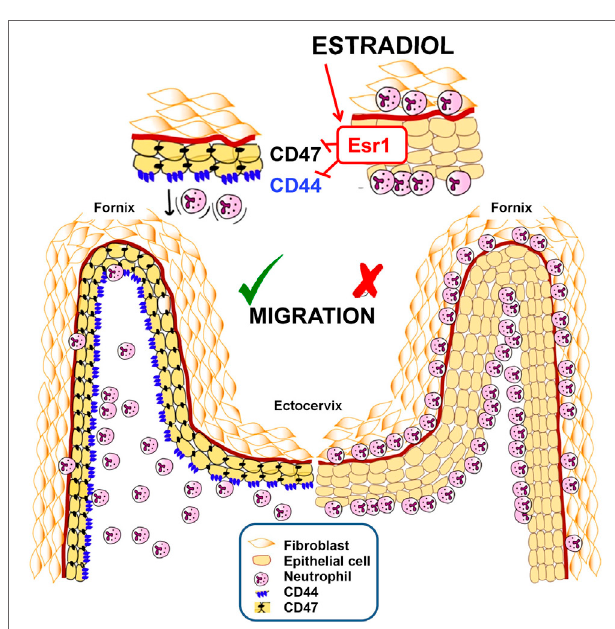
FigUre 11 | Summarizing schematic figure. Progesterone treatment promotes neutrophil migration to the vaginal lumen. In contrast, estradiol treatment downregulates CD44 and CD47 expression in the cervix and fornix epithelial cells, by an ESR1-dependent mechanism, which accumulates neutrophils in the sub- and supra-epithelial spaces of the ectocervix and vaginal fornix rather than at the vaginal